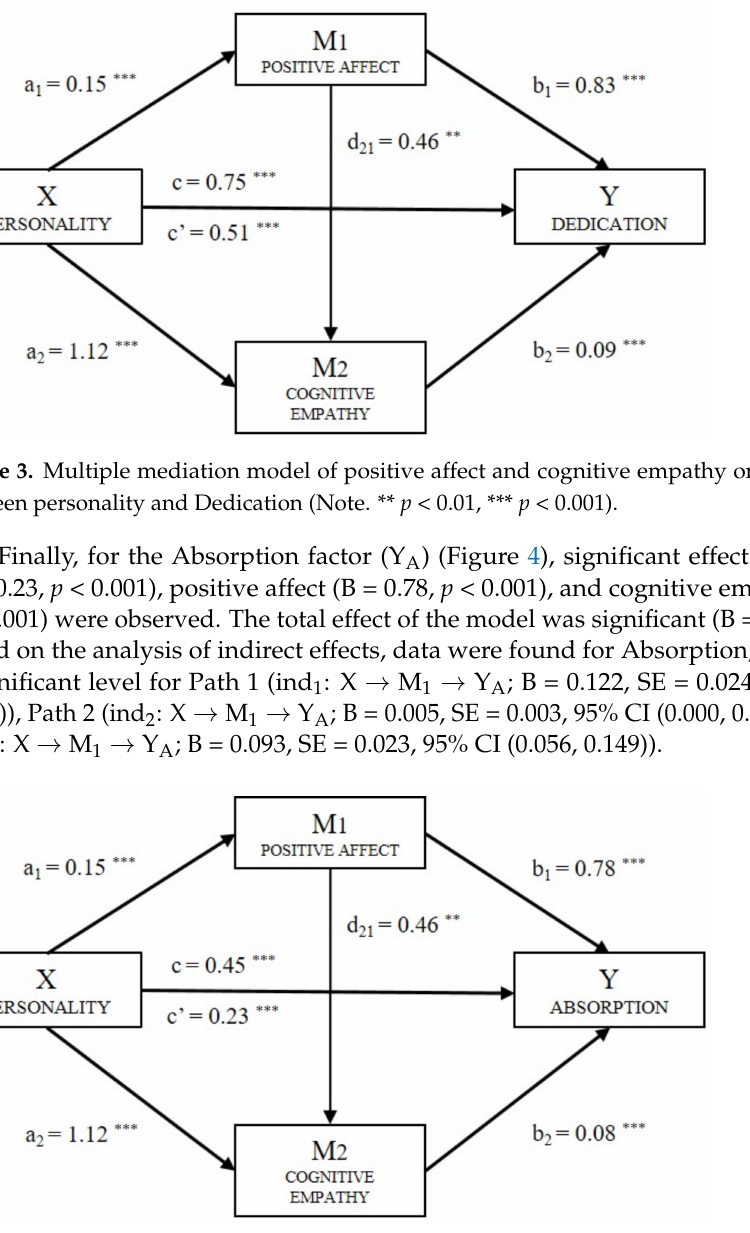
Figure 4. Multiple mediation model of positive affect and cognitive empathy on the relationship between personality and Absorption (Note. ** p < 0.01, *** p <